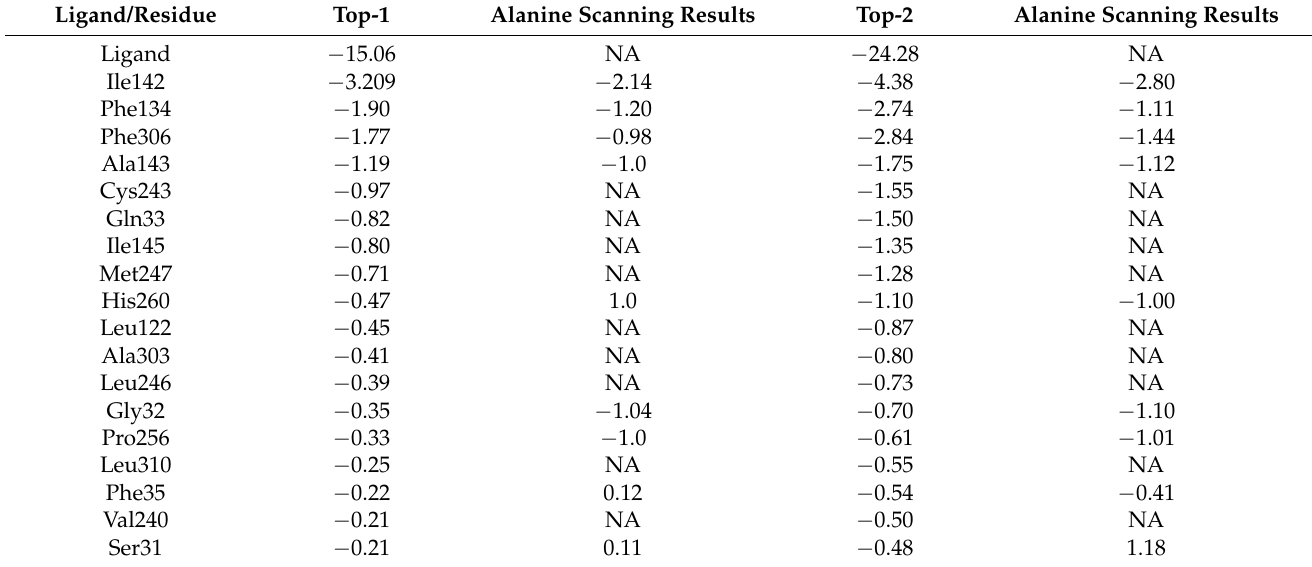
Table 3. Net binding energy value of compounds and their interacting residues that are highly stable in complex formation in simulation time. The energy values are given in kcal/mol. Moreover, alanine scanning results when key compounds interacting residues are mutated to alanine. NA (not